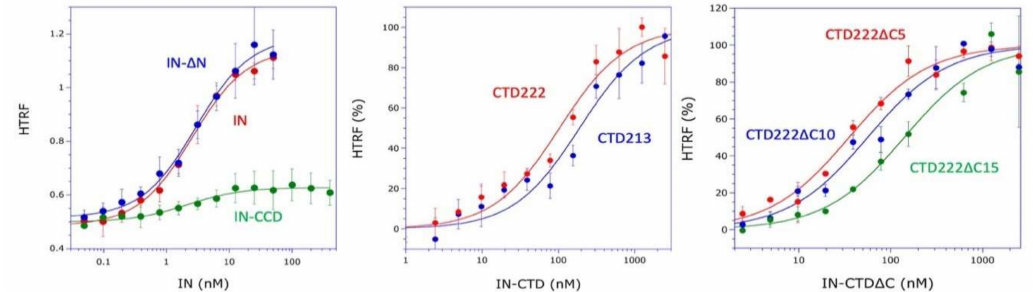
Figure 2. Association of the derivatives of IN with mLysRS. The binding a ffi nities of mLysRS to IN constructs were determined in an HTRF assay using 1.5 nM of HA-tagged mLysRS and increasing concentrations of His-tagged IN derivatives, expressed as dimer (IN, IN- ∆ N, IN-CCD) or monomer (CTD213, CTD222, CTD222 ∆ C5, CTD222 ∆ C10, CTD222 ∆ C15) concentrations. Experimental values (symbols) were fit (curves) to a binding equation assuming that one molecule of IN binds one molecule of mLysRS. The binding constants and the associated standard deviations ( n = 3) are indicated in Figure